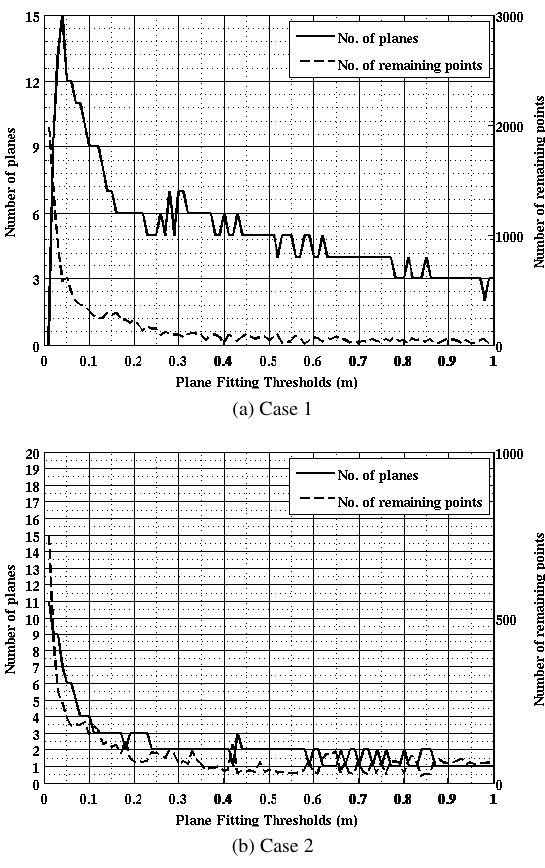
Figure 7: Threshold determination process for the RANSAC al- gorithm. The correct threshold seems to settle in between σ h and 1 . 5 σ